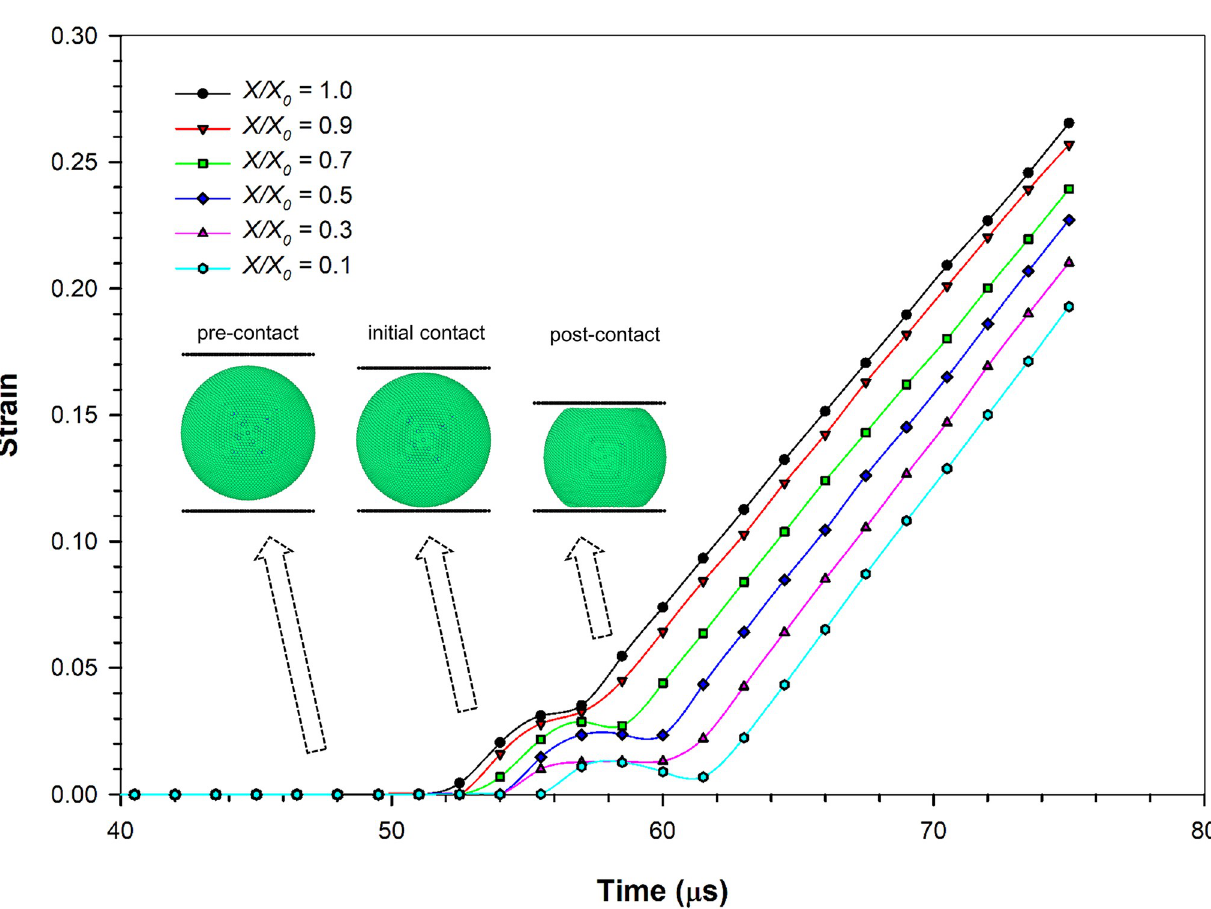
Fig 5. Variation of average strain with time during compression simulation of the SPH-CG cell drying model at a turgor pressure of 200 kPa. ( X/X 0 is the normalised moisture content).